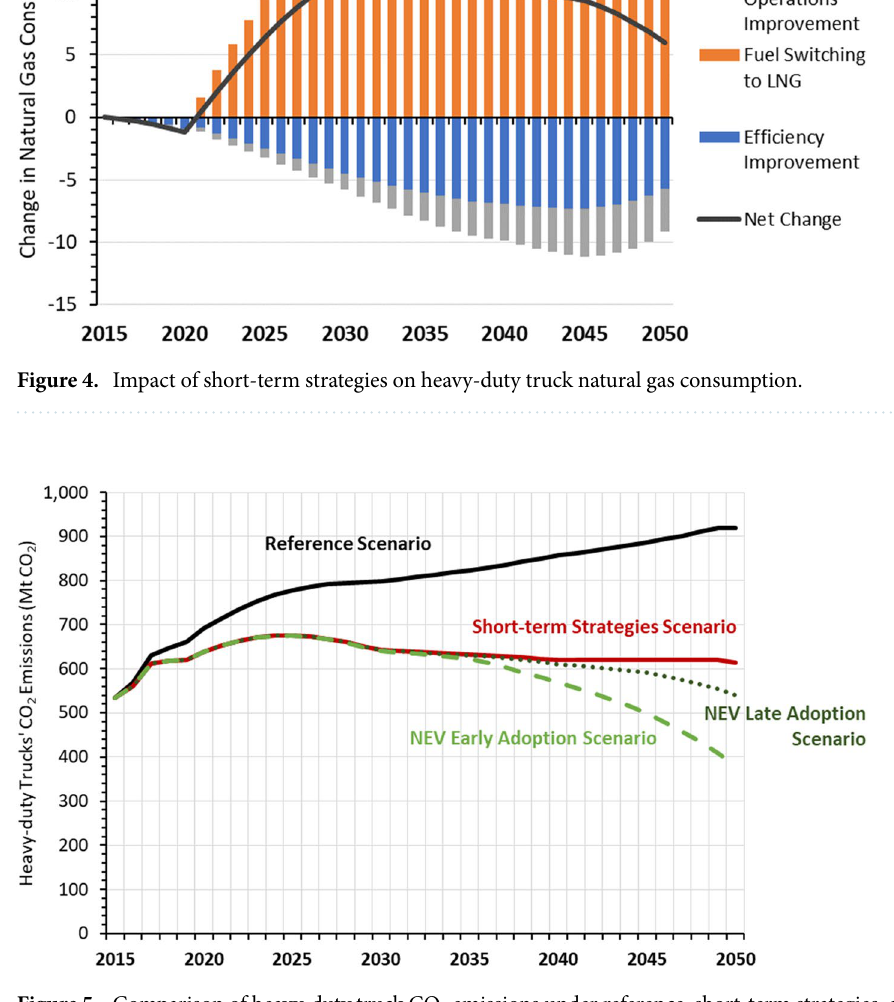
Figure 5. Comparison of heavy-duty truck CO 2 emissions under reference, short-term strategies, and NEV adoption